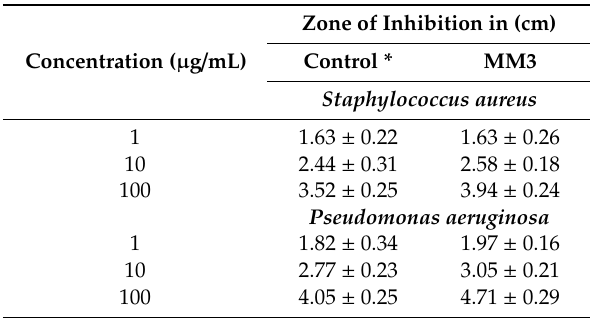
Table 4. Antimicrobial efficacy of the optimized formulation (MM3).